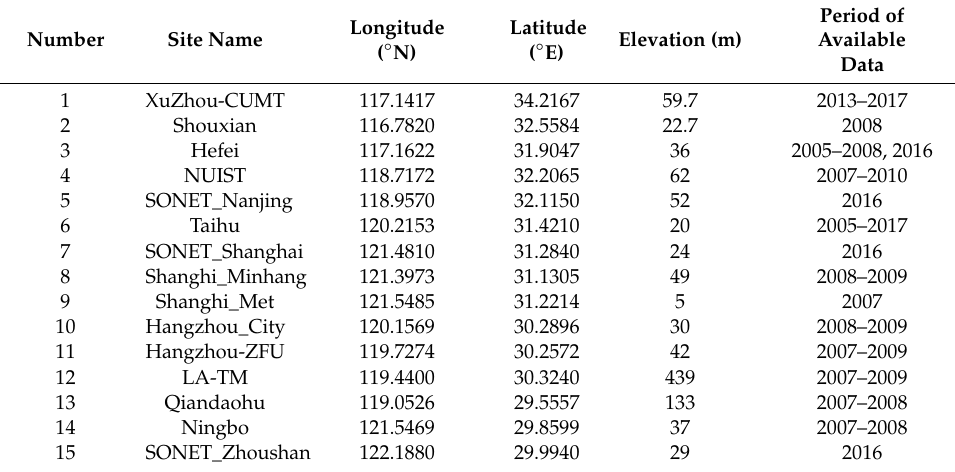
Table 2. Locations of the Aerosol Robotic Network (AERONET) sites within the Pan Yangtze River Delta (PYRD) (see Figure 1) and the periods of their available